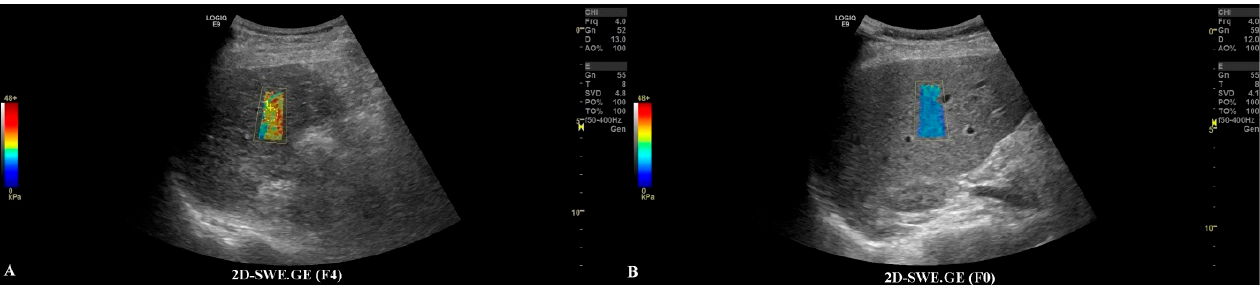
Figure 2. In frame ( A ), we have depicted a cirrhotic liver evaluated by the 2D-SWE.GE technique, where the color-coded map points out a reddish color, compared with frame ( B ), where the color-coded map depicts a blue color, meaning the absence of fibrosis.